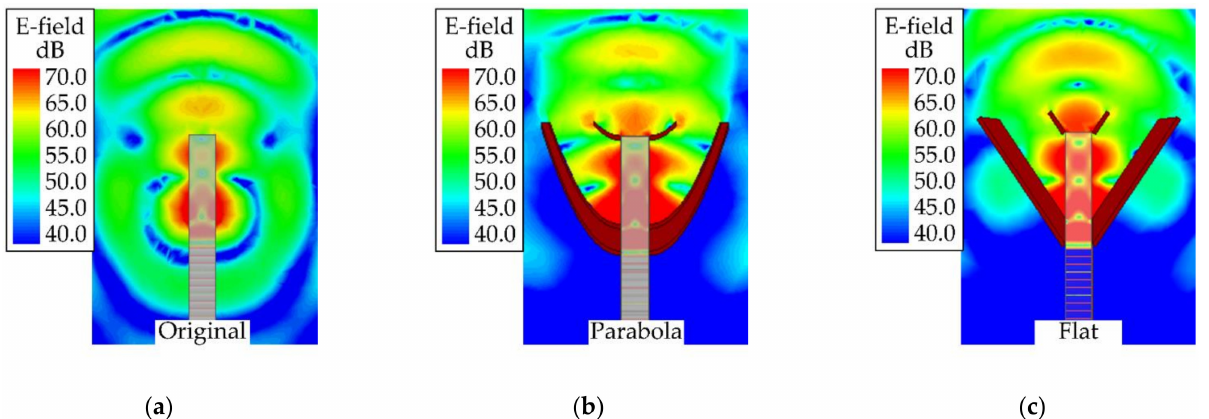
Figure 3. Simulated E-plane field distributions and radiation patterns of three investigated antennas at 22.7 GHz. ( a ) Original antenna; ( b ) parabola horn; ( c ) flat